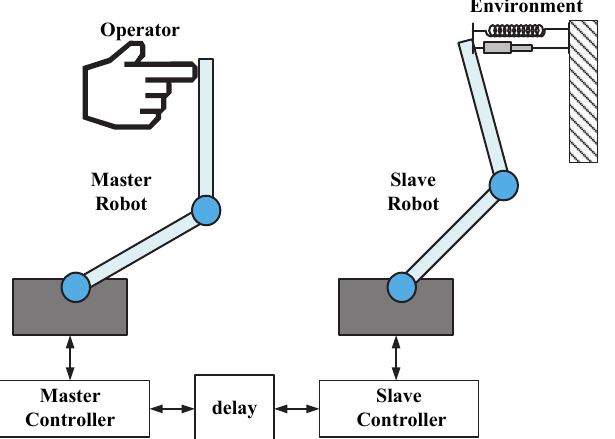
Figure 2. The block diagram of the simulation experiment.